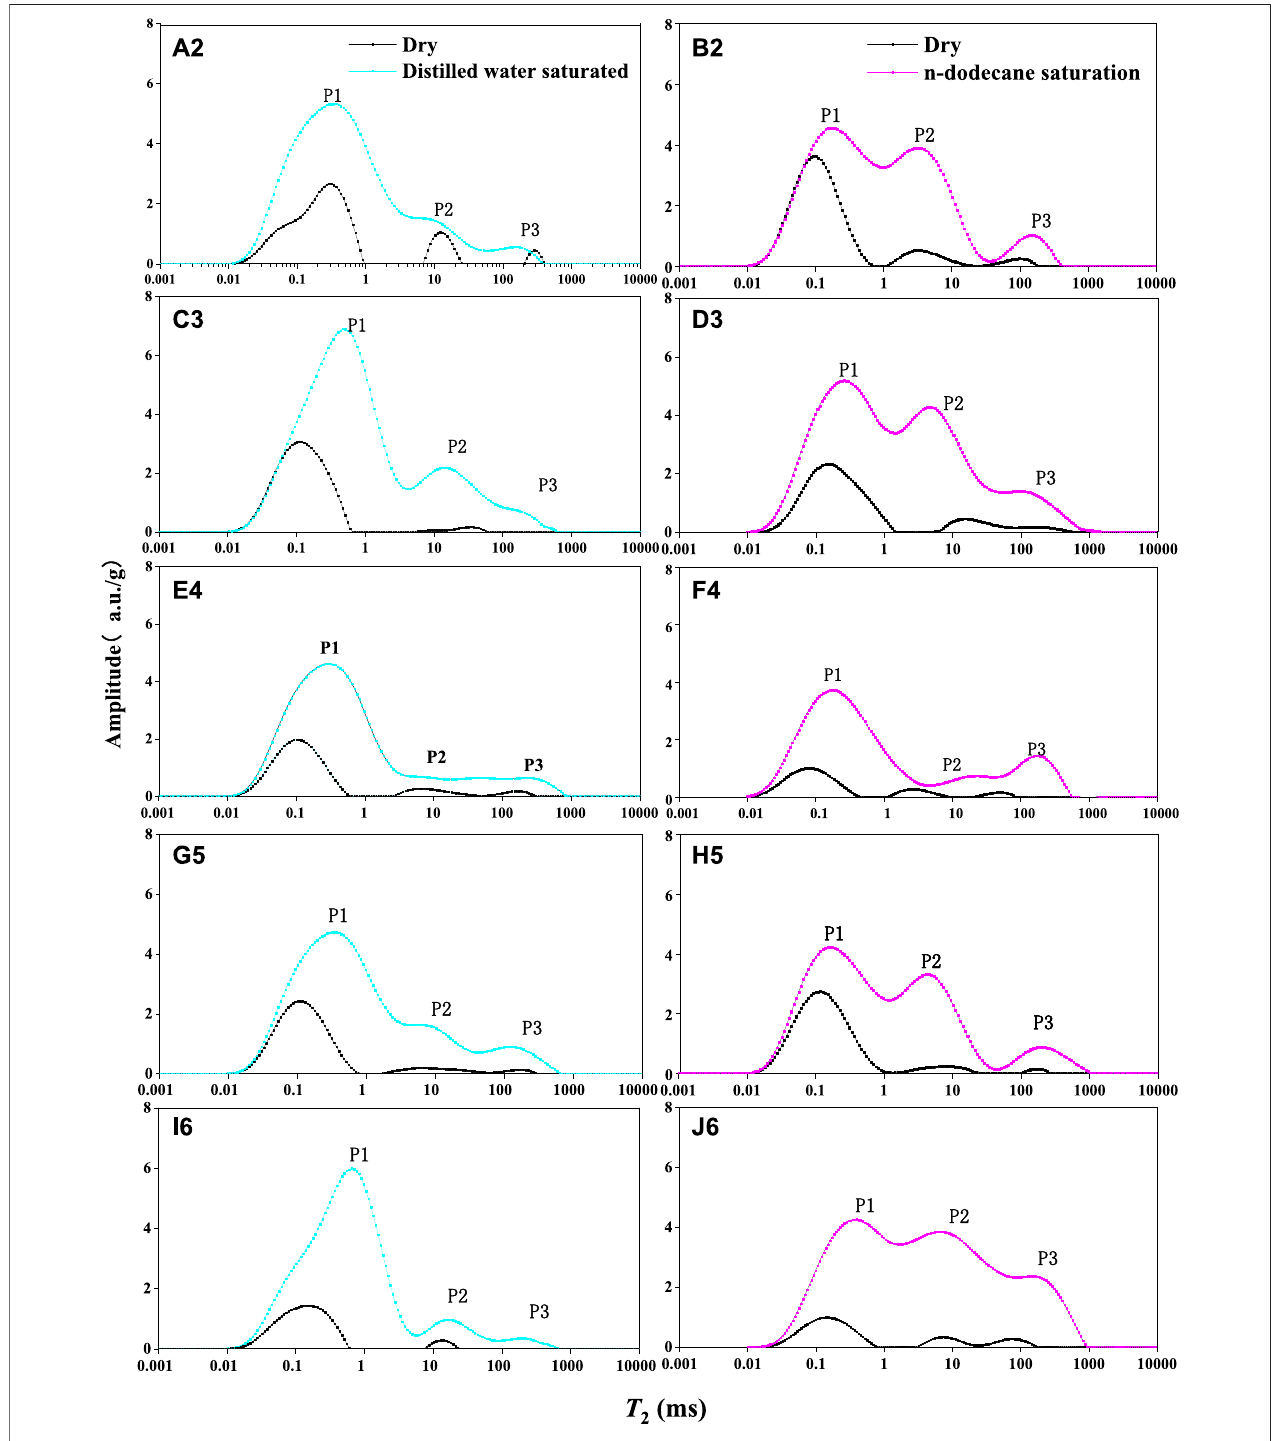
FIGURE7| T 2 spectrafor fi vesamplesfromShahejiemember;a.u.:absoluteunit: (A,C,E,G,I) DIW-saturated(leftpanel); (B,D,F,H,J) Dodecane-saturated(rightpanel).